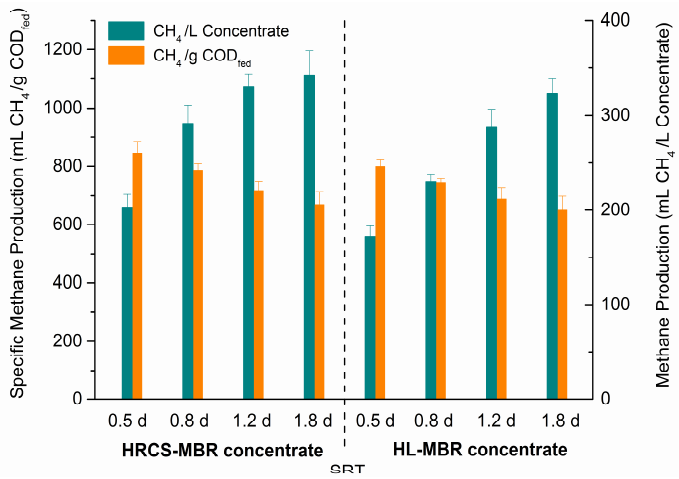
Figure 6. Cumulative methane productions of each MBR concentrate at different SRTs.